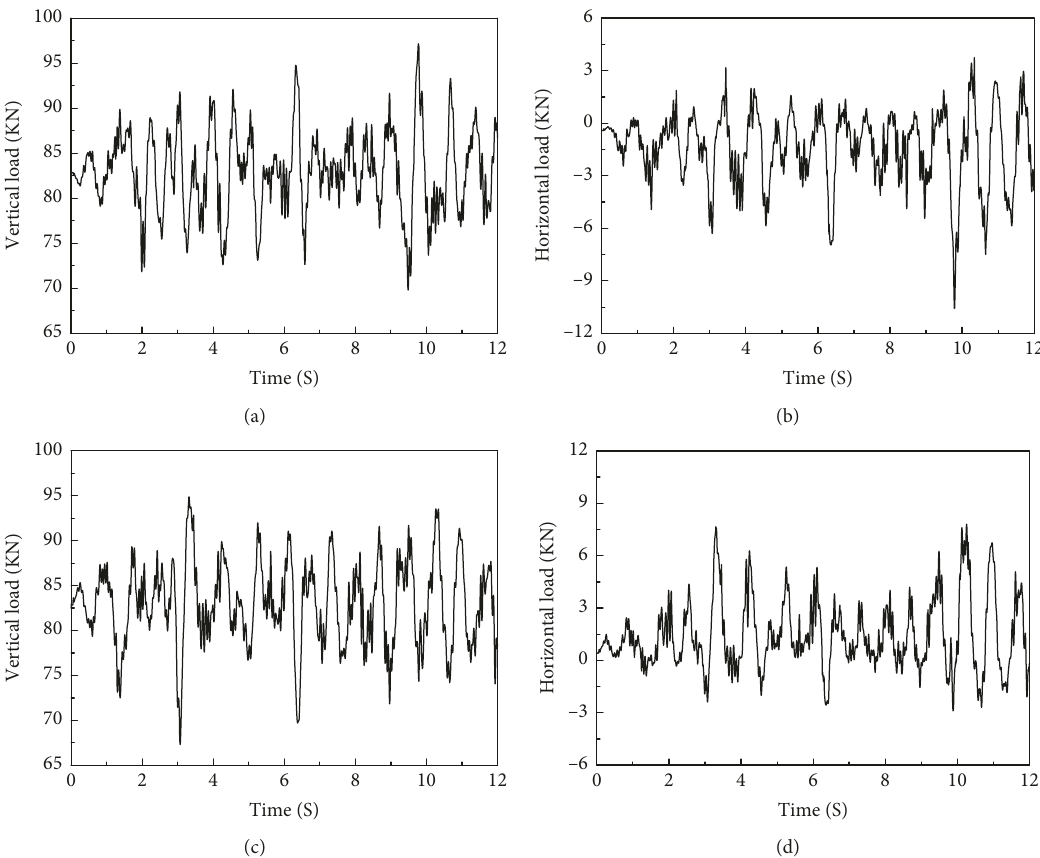
Figure 8: Wheel-rail force of the first wheel pair of the personnel quota scenario trailer. (a) Vertical force of the left rail. (b) Horizontal force of the left rail. (c) Vertical force of the right rail. (d) Horizontal force of the right rail.